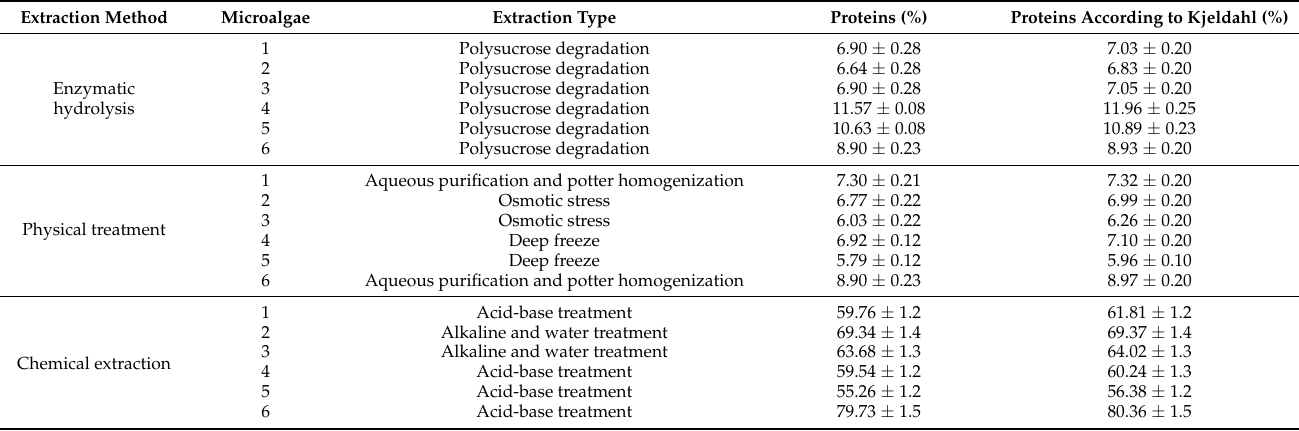
Table 2. Proteins in different extraction methods.